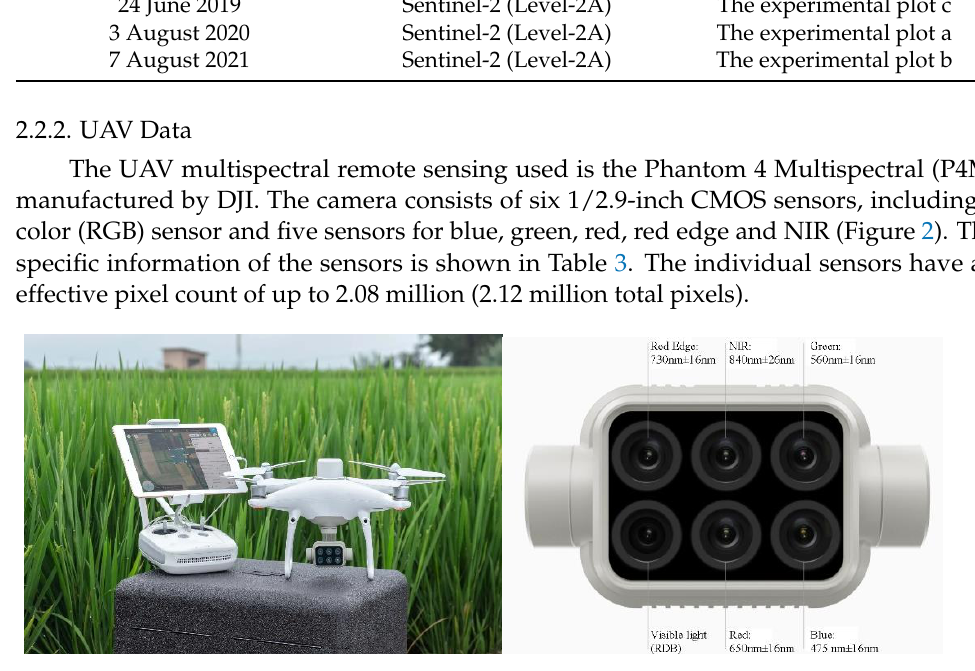
Figure 2. The unmanned aerial vehicle Phantom 4 Multispectral ( left ) and multispectral camera ( right ). Table 3. Phantom 4 Multispectral sensor spectrum